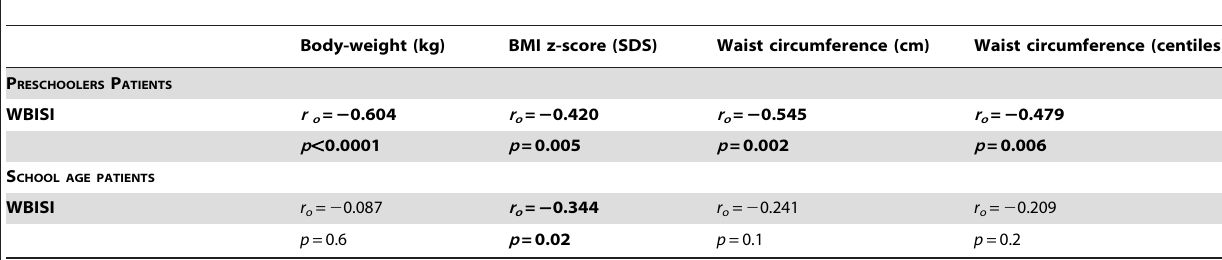
Table 2. Correlation analysis for age-adjusted WBISI in preschool and school age obese patients.